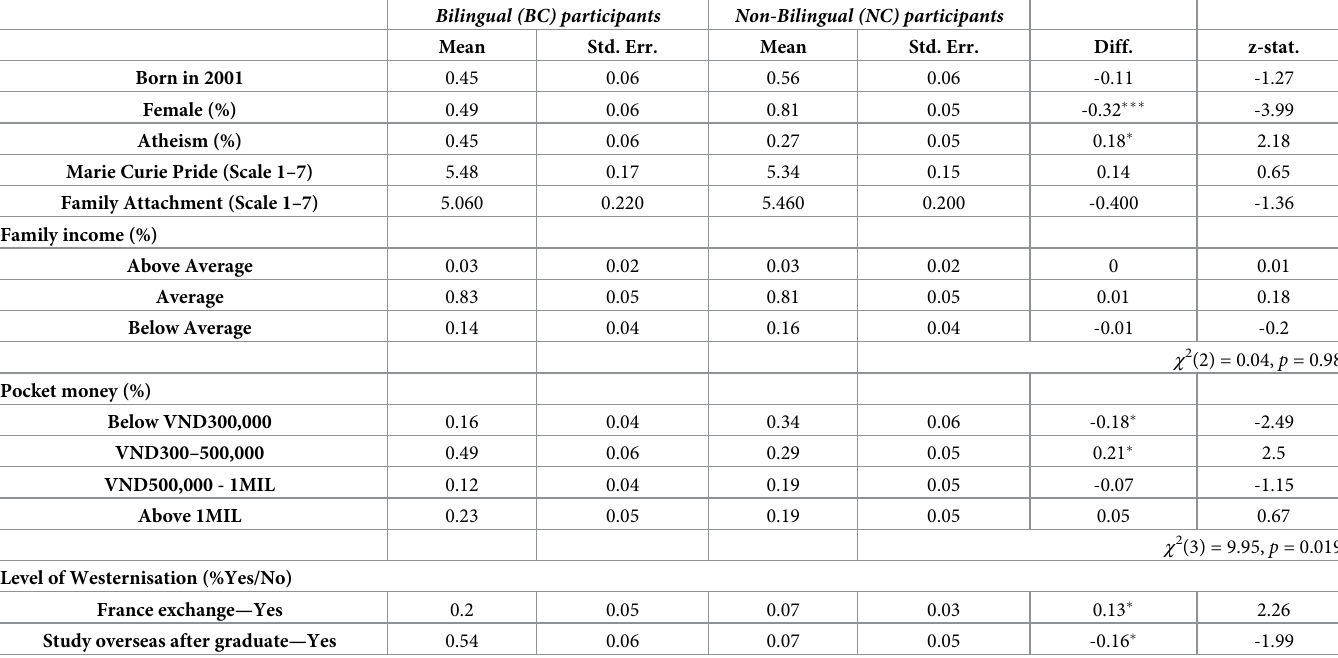
Table 1. Characteristics of bilingual versus non-bilingual